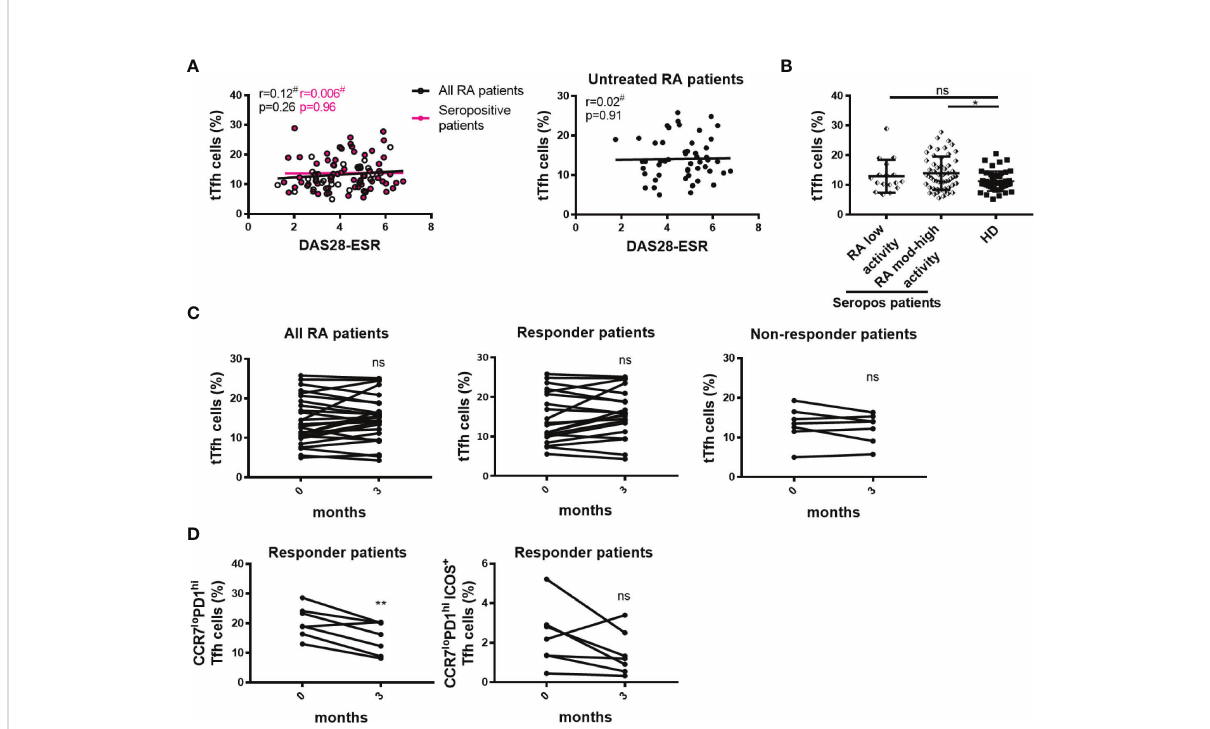
FIGURE 6 Relationship between tTfh cells and the activity of the disease. (A) Correlation between DAS28-ESR and tTfh cell frequency in all RA patients (n=99, empty black circles and line) or in only seropositive patients (n=72, pink circles and line) (left), and in untreated RA patients (n=52) (right). (B) Frequency of tTfh cells in seropositive RA patients (Seropos, n=72) with low (n=17) or moderate-high (n=55) disease activity and HD (n=46). (C) Frequency of tTfh cells at baseline (0 months) and after 3 months of treatment in all RA patients (n=27) (left), in responder (n=20, middle) and non-responder (n=7, right) RA patients. (D) Frequency of CCR7 lo PD1 hi Tfh cell subset (left) and activated CCR7 lo PD1 hi ICOS + Tfh cell subset (right) at baseline (0 months) and after 3 months of treatment in responder RA patients (n=7). Symbols represent individual subjects. Mean ± DS is shown in (B) . # Pearson ’ s correlation coef fi cient r and P values are shown in (A) . Lines of best fi t were drawn. One-way Analysis of Variance (ANOVA) followed by Bonferroni Multiple Comparisons Test were calculated in (B) . P values were determined by Paired samples t-test in (C) and (D) . Two-tailed probability * p < 0.05, ** p < 0.01, ns, not signi fi